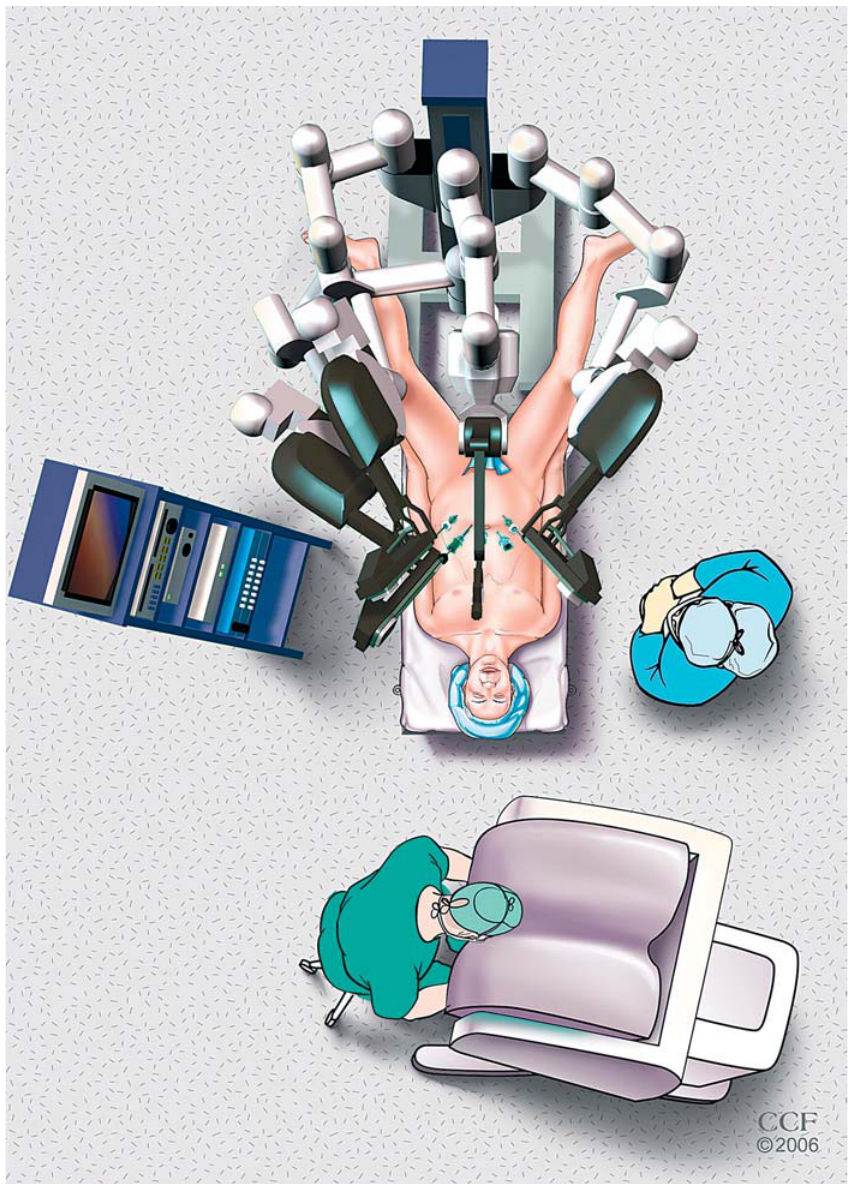
Figure 1 – Patient placed in the supine position with the legs spread to accommodate the robot. Note that the primary assistant is positioned on the right side of the patient and the 4th robotic arm used for traction is positioned at the left side at the patient’s